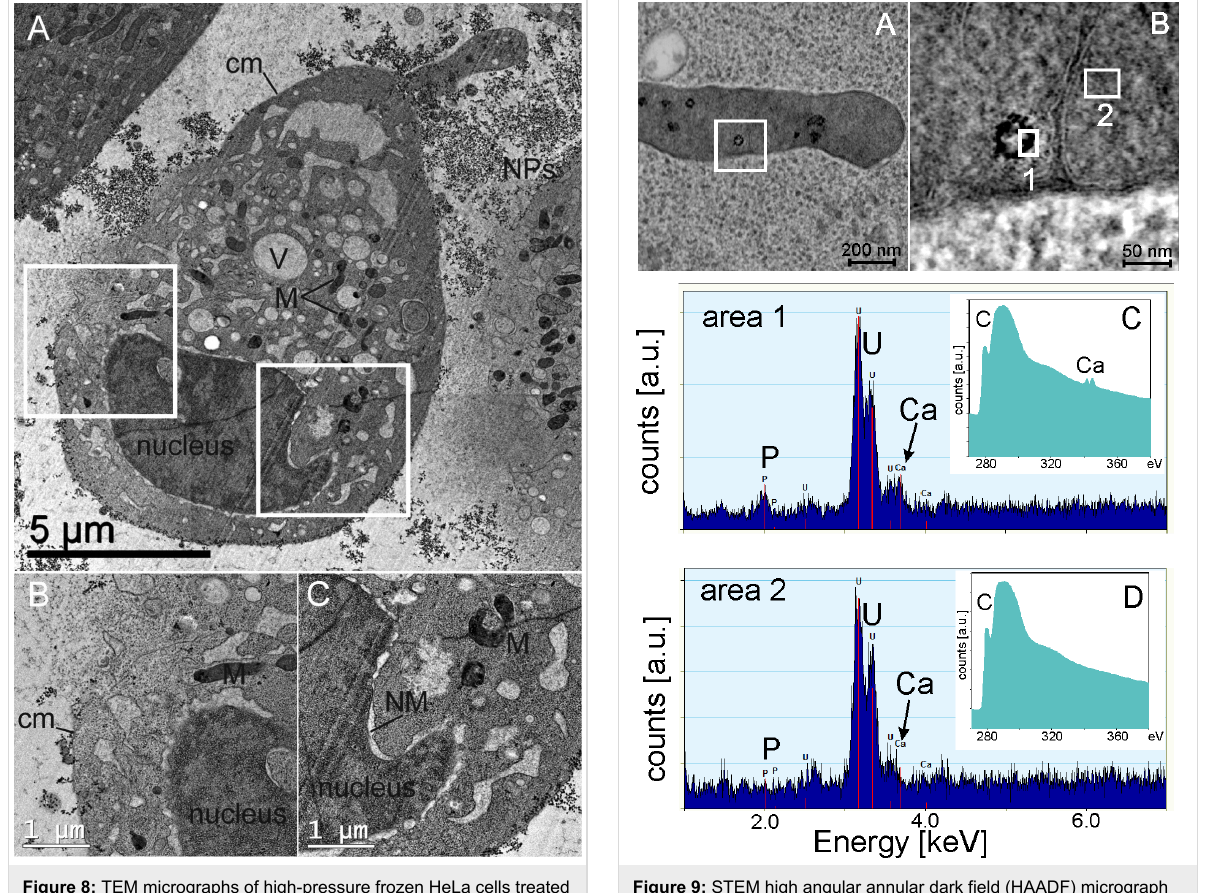
Figure 8: TEM micrographs of high-pressure frozen HeLa cells treated with 3400 µg·mL − 1 of Si-NP22 for 2 h. B and C are close-ups of the central cell in A, showing the cell membrane (cm) leakage and the nuclear membrane (NM) disintegration in more detail. Additionally labeled in the micrograph are the mitochondria (M) and the vacuoles (V).